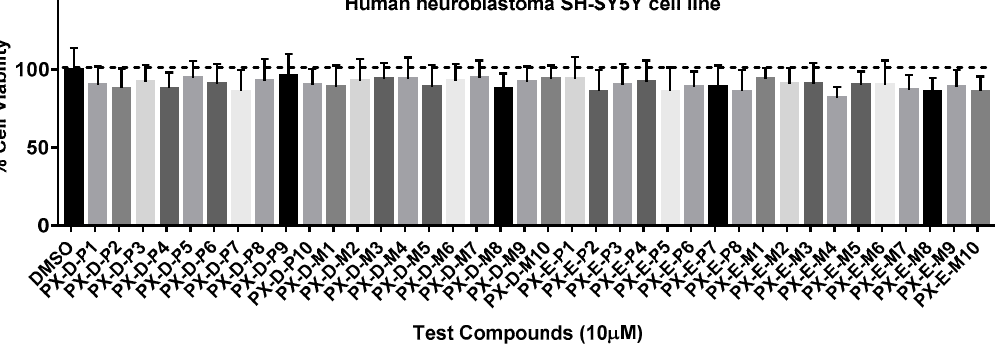
Figure 6. Cytotoxicity of test compounds against human neuroblastoma SH-SY5Y cell line was measured by the MTT method after 24 h. The values are displayed as mean ± SD.